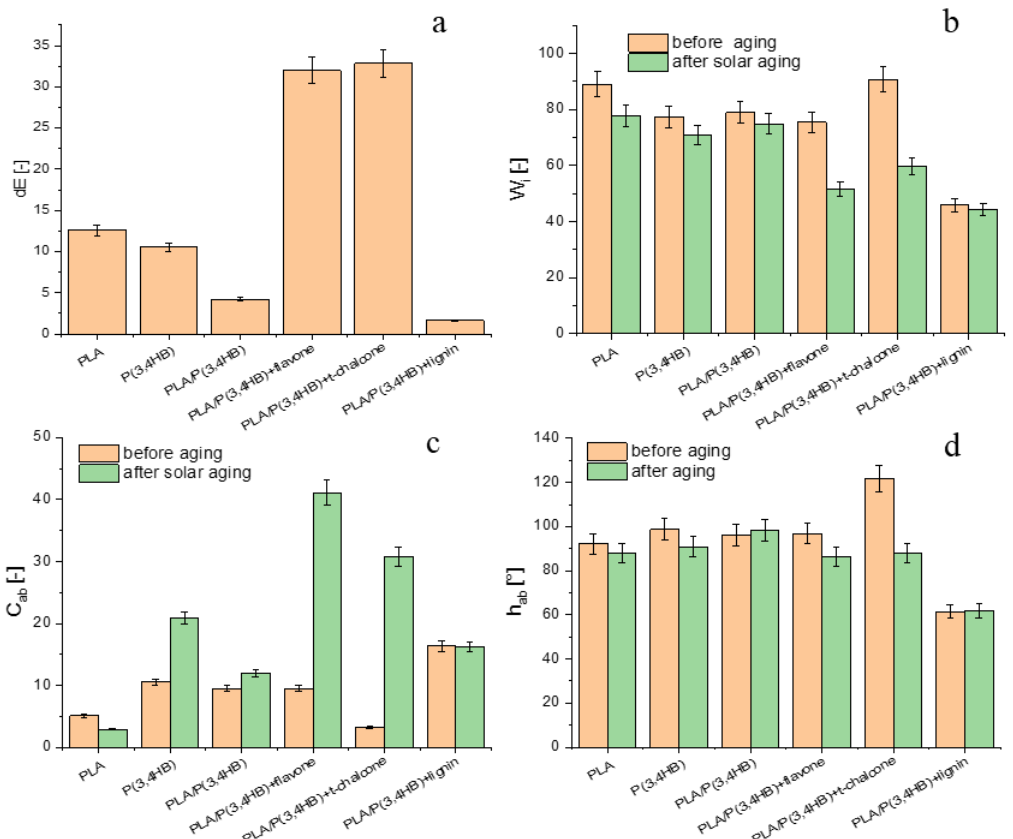
Figure 8. The impact of solar aging on: ( a ) change of colour (dE). ( b ) whiteness index ( W i ). ( c ) chroma ( C ab ). ( d ) hue angle ( h ab ) of aliphatic polyester composites containing natural antioxidants.